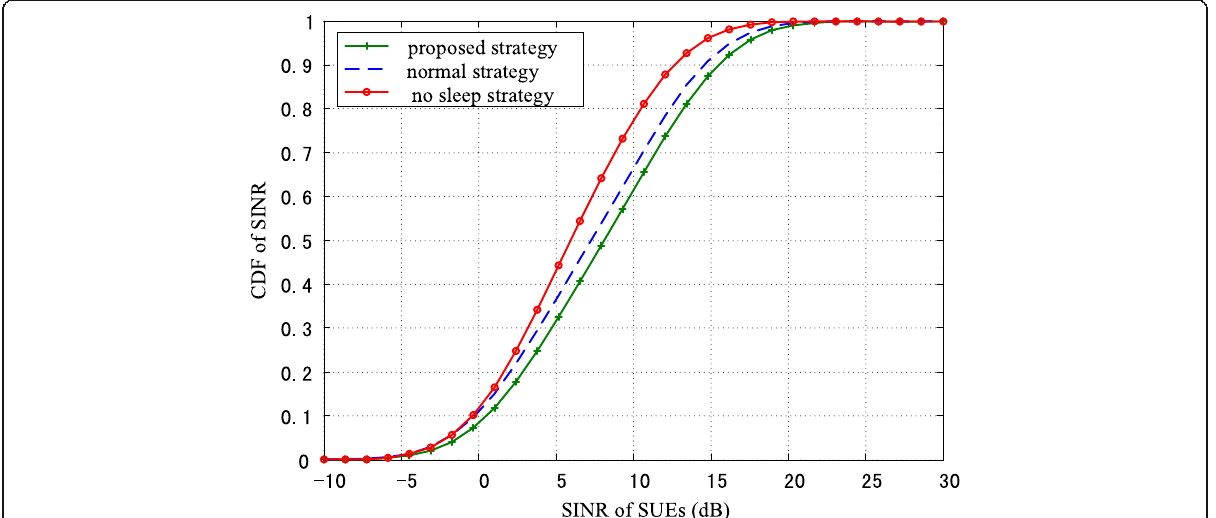
Fig. 2 SUEs ’ SINR CDF. The cumulative distribution function (CDF) of the SUEs ’ SINR in the system is shown in Fig. 2. Since the use of the normal strategy which is similar to the one in [15] can improve the SINR performance of SUEs, the interference among small BSs is serious. The proposed strategy claims to share the whole spectrum between the clusters which effectively reduce the co-tier interference in the HetNet system. Therefore, it is more advantageous to improve the SINR performance of the SUEs